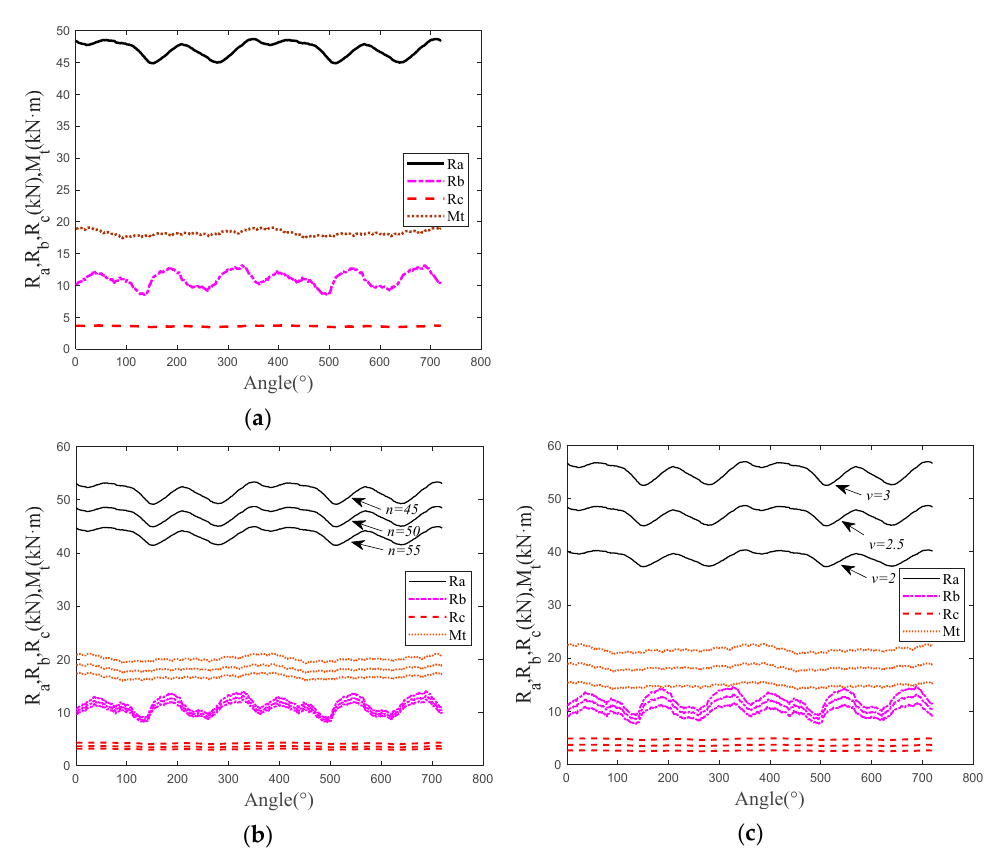
Figure 4. Influence of cutting parameters on cutting head load : ( a ) loading curve at P k = 350 and ( b ) the load comparison curve at different rotating speeds and ( c ) the load comparison curve at different swinging speeds.